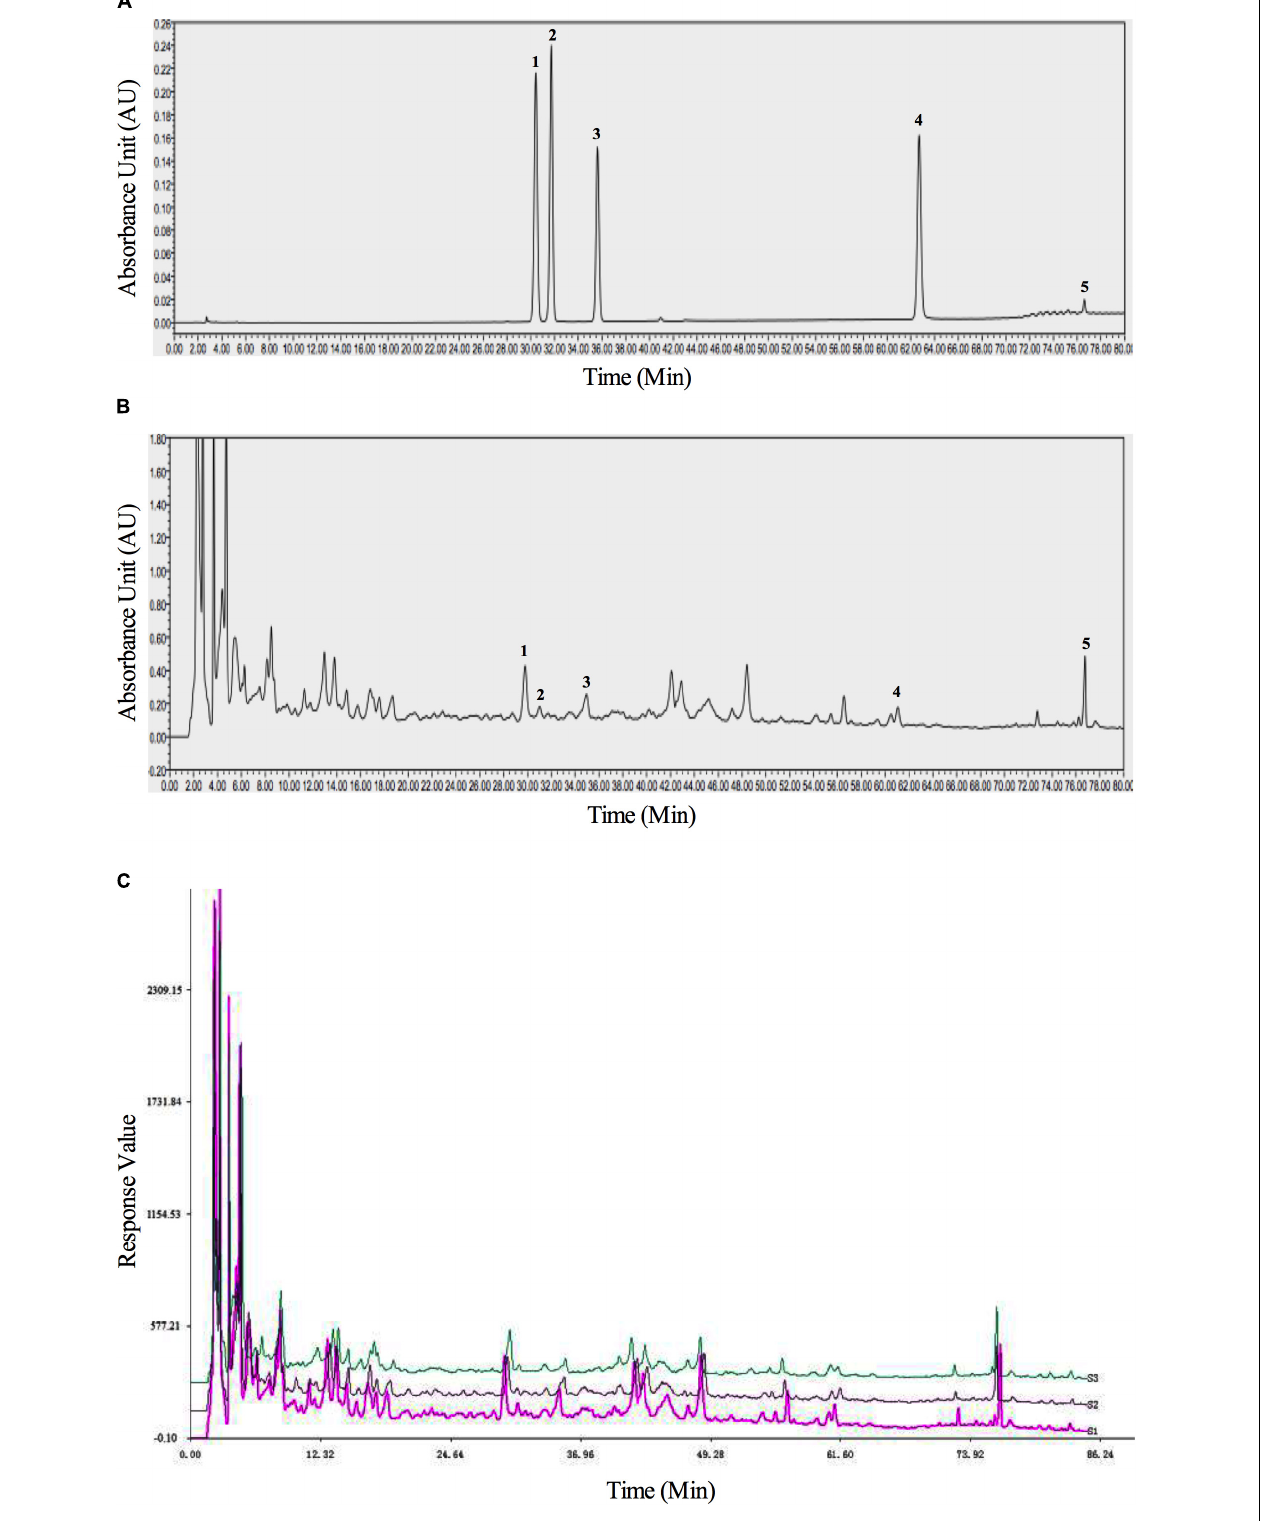
Frontiers in Pharmacology |